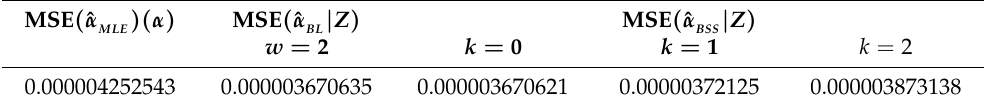
Table 16. Results of calculated MSE for ˆ α .